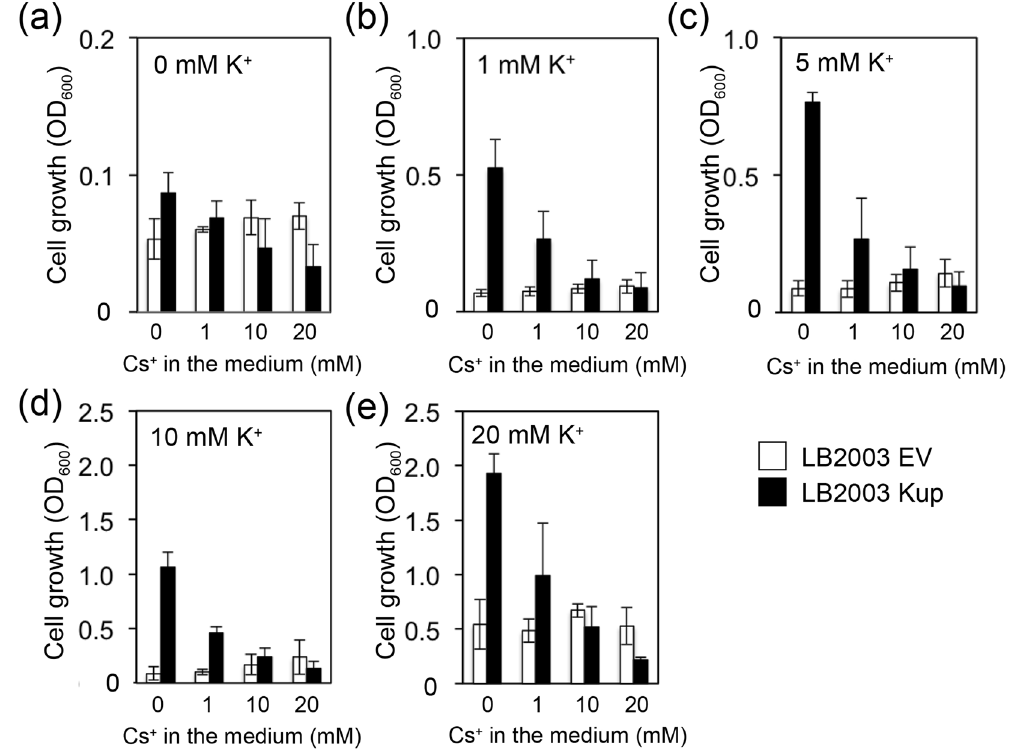
Figure 3. Comparison of growth of the K + uptake system-deficient E . coli strain LB2003 transformed with Kup or the empty vector (EV) at various concentrations of K + and Cs + . Cells grown in minimal medium containing 20 mM K + were collected by centrifugation, washed with K + -free buffer and then inoculated into minimal medium supplemented with combinations of various concentrations (0–20 mM) of K + and Cs + . Growth was determined after 24 h-incubation at 30 °C. ( a ) 0 mM K + , ( b ) 1 mM K + , ( c ) 5 mM K + , ( d ) 10 mM K + , ( e ) 20 mM K + . The error bars represent mean ± S.D (n = 3). LB2003 strain containing Kup (black bars) or EV (white bars).